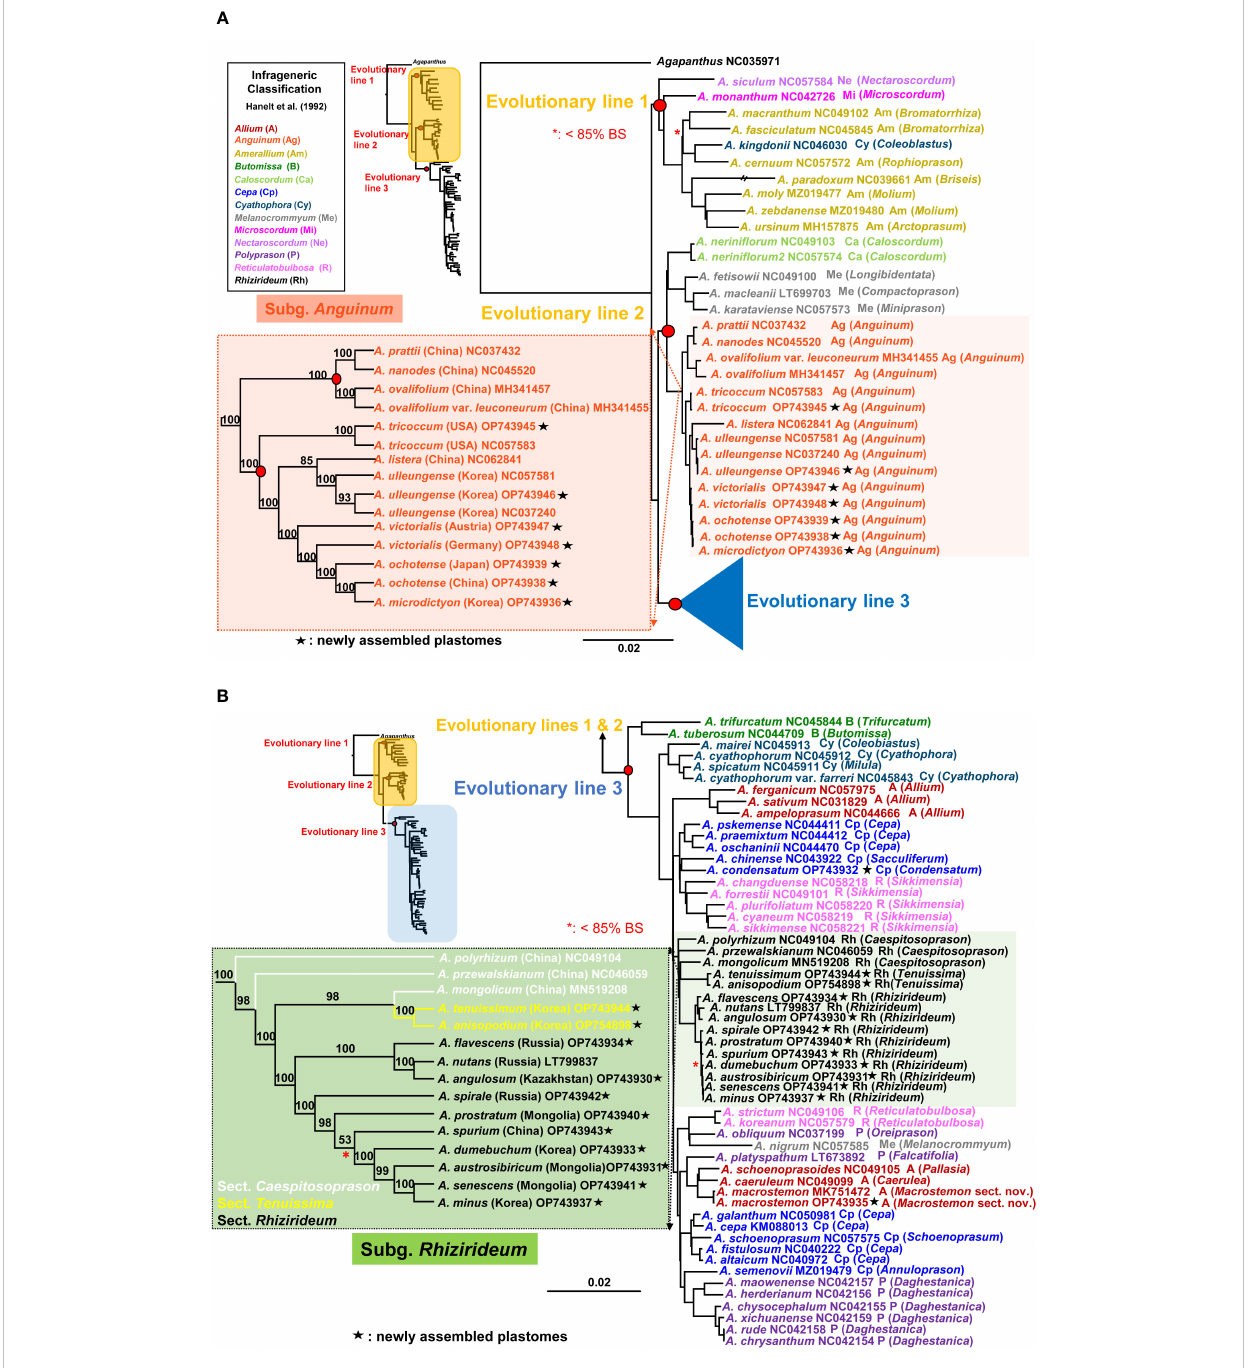
FIGURE 4 Maximum likelihood (ML) tree of the genus Allium based on 84 accessions representing 76 species. (A) A partial ML tree showing the fi rst and second evolutionary lines of Allium , with enlargement of subg. Anguinum . Node with < 85% bootstrap support (BS) is shown in red asterisk. (B) A partial ML tree showing the third evolutionary line of Allium , with enlargement of subg. Rhizirideum . Node with < 85% bootstrap support (BS) is shown in red asterisk. Newly assembled plastome in this study is shown in black asterisk. Subgenera (Hanelt et al., 1992) are indicated in different colored labels. A species name is followed by a NCBI accession number, a subgeneric abbreviation, and a section in